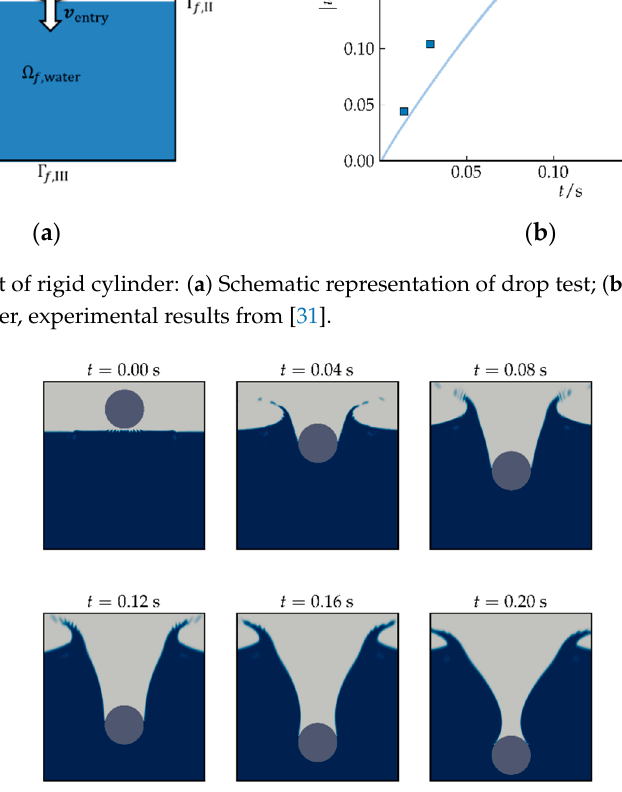
Figure 5. Stages of water impact of rigid cylinder .